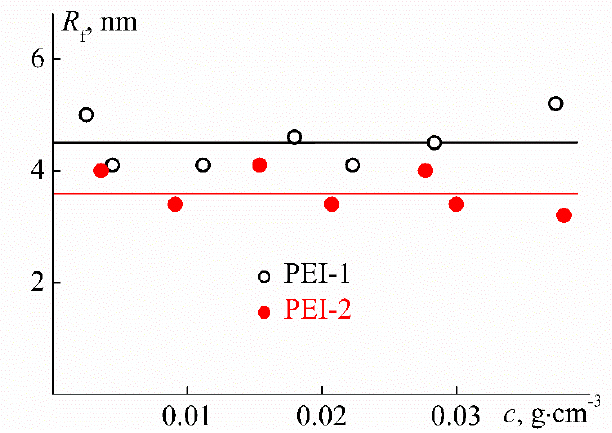
Figure 11. The concentration dependence of hydrodynamic radius R f for aqueous solutions of PEI-n samples at 10 °C.